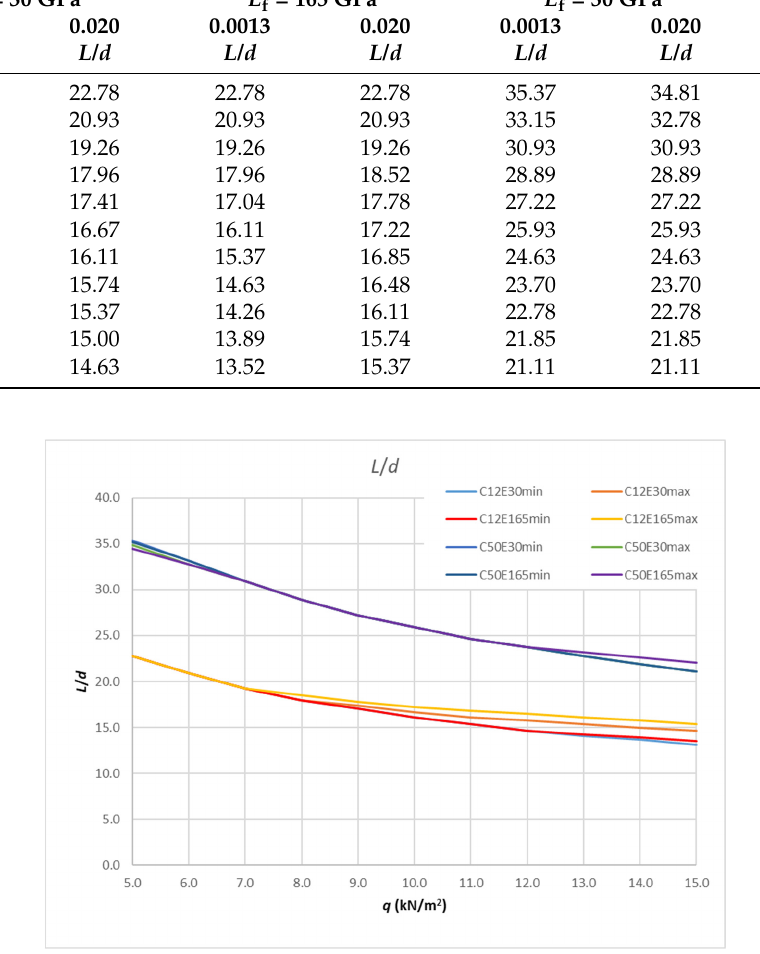
Figure 12. Results of parametric analysis. Table 10. Slenderness limit envelope values.